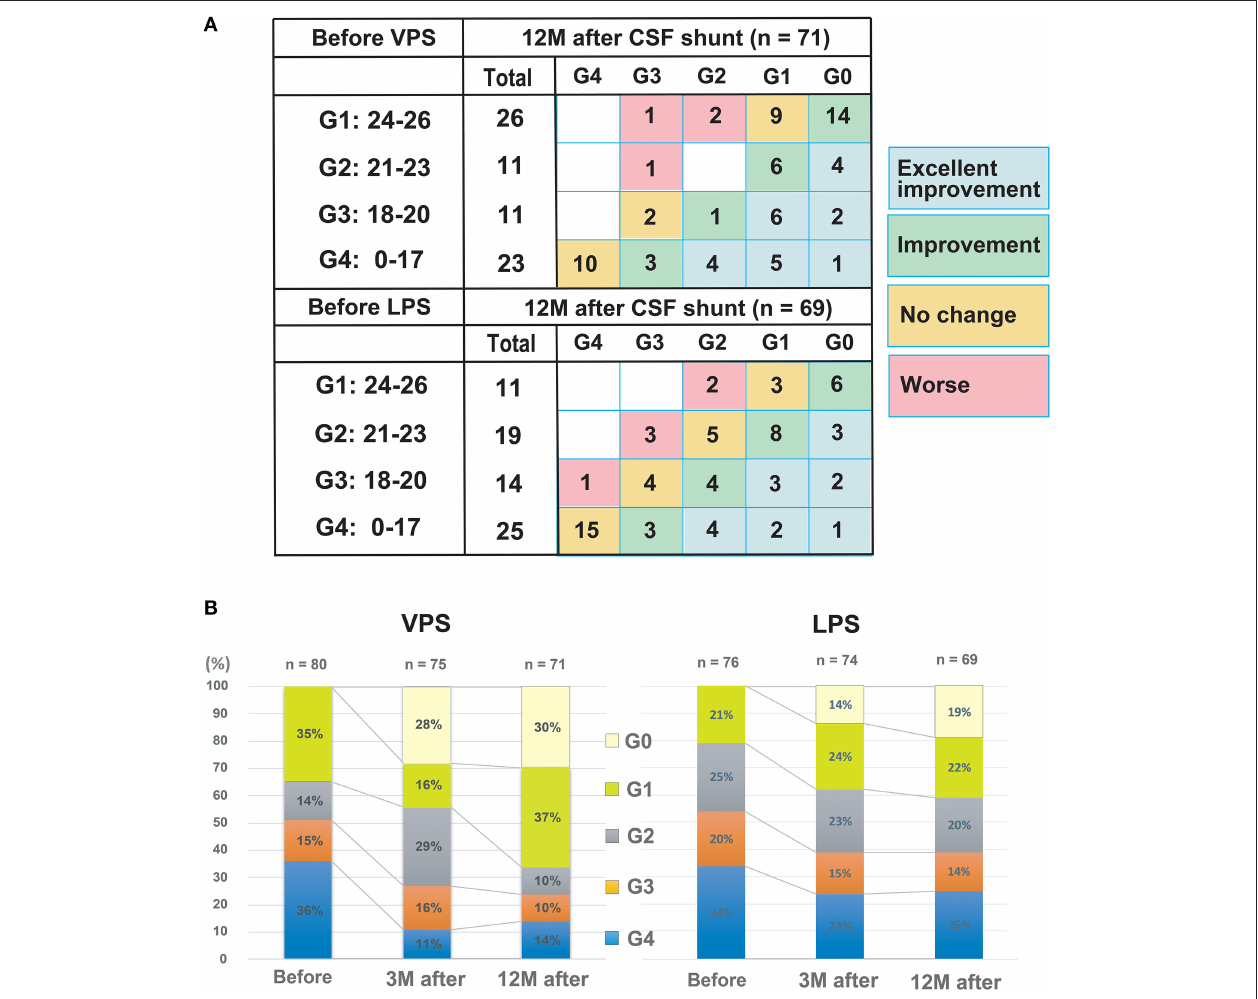
FIGURE 4 | MMSE score changes between before and 12 months after shunting. (A) The distribution of preoperative and postoperative grades of dementia severity, according to the MMSE scores. Numbers in each box indicate the number of patients. Spearman’s rank correlation coefficient ( ρ ) and p -value between before and 12 months after shunting are ρ : 0.51 ( p < 0.001) in VPS and ρ : 0.66 ( p < 0.001) in LPS cohort, respectively. (B) Changes after shunt treatment in severity classification by MMSE scores. CSF, cerebrospinal fluid; MMSE, Mini-Mental State Examination; LPS, lumboperitoneal shunt; and VPS, ventriculoperitoneal